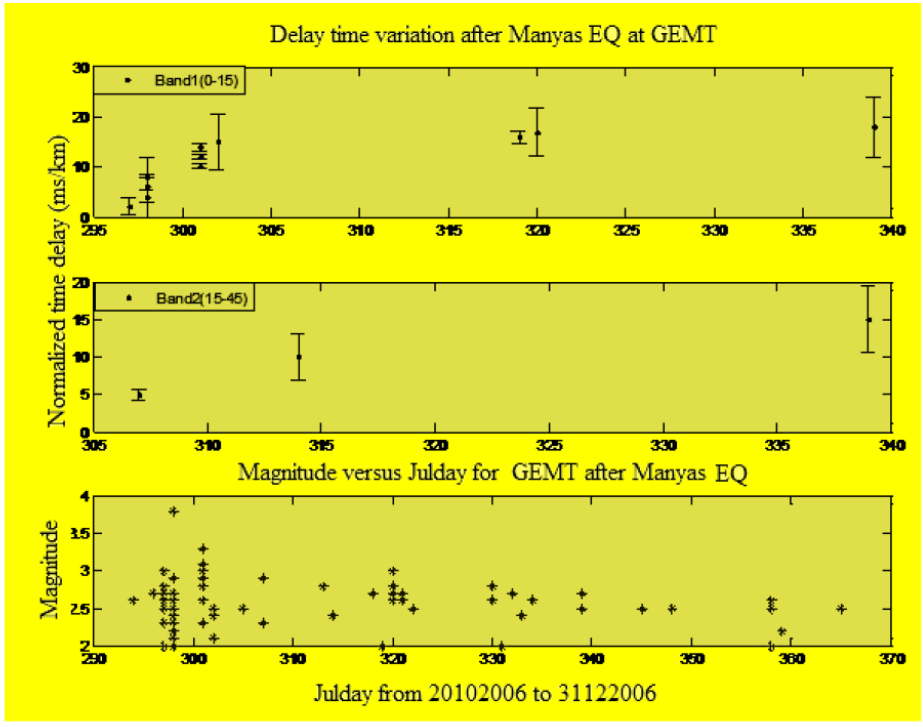
Fig. 10. Changes in delay time after the main earthquake at station GEMT. Micro earthquakes after the main earthquake occurred. They are marked